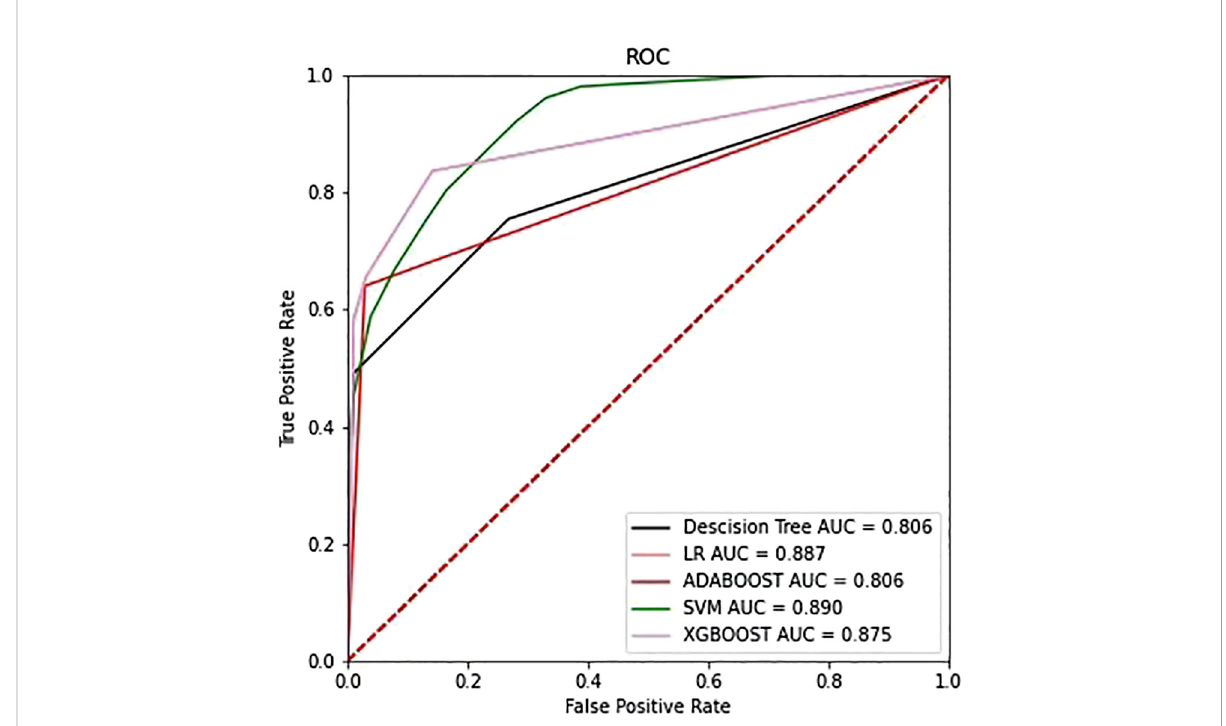
FIGURE 6 The ROC curves of the top four models selected from the training phase on the testing